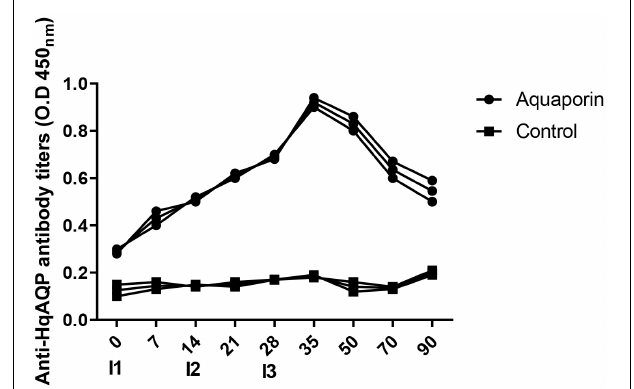
FIGURE 7 | Analysis antibody response of rabbit against HqAQP1 peptide 2 by ELISA assay. Relative readings from ELISAs are plotted against trial day number for both the rabbit group and the control group inoculated with PBS. Sera was collected on days 0 (I1), 7, 14 (I2), 21, 28 (I3), 35, 50, 70, and 90 of the tests. All serum samples were analyzed in